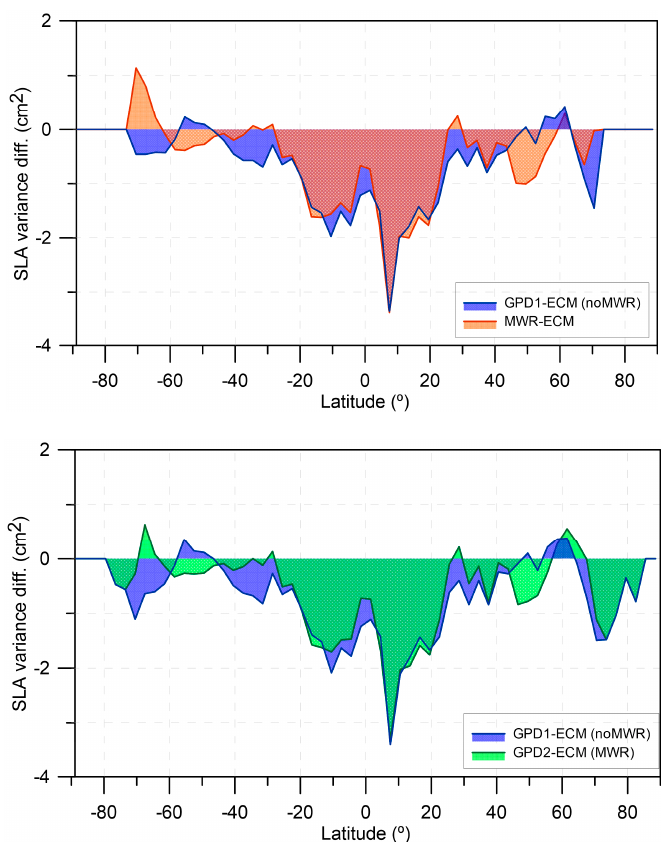
Figure 20. ( Top panel ): variance differences of SLA versus latitude, for SLA datasets computed using the WTC from the MWR and ECMWF (orange) and those from GPD1 and ECMWF (blue), over the period of S3A cycles 05 to 16 and using only points with a valid MWR; ( Bottom panel ): variance differences of SLA versus latitude between GPD1 and ECMWF (blue) and between GPD2 and ECMWF (green), over the period of S3A cycles 05 to 16 using all points with valid SLA.